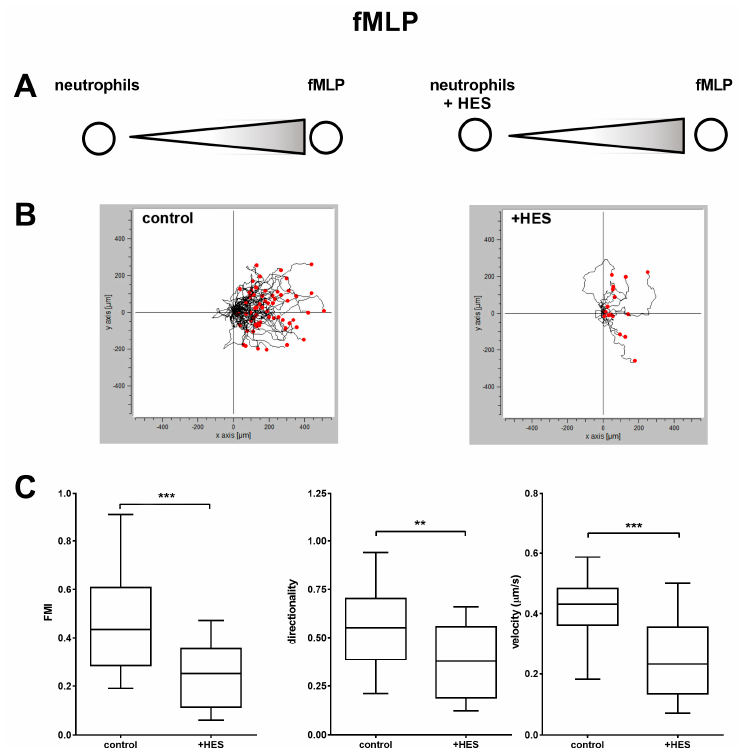
Figure 4. Migration of neutrophils not treated (control) or treated (+ HES) with Hydroxyethyl starch in response to fMLP. Low magnification time-lapse images were obtained and processed using cell-tracking algorithms. ( A ) Experimental setup. ( B ) Detailed migration trajectories of representative cells from control ( n = 62) and HES-treated ( n = 17) cells; individual tracks were transposed so that each had its start at the origin. ( C ) Comparison of forward migration index, directionality, and velocity. As can be seen, the cells pre-treated with HES showed a decreased FMI, directionality and velocity compared to the control. The results are the mean ± SD of three independent experiments. ** p < 0.01, *** p < 0.001